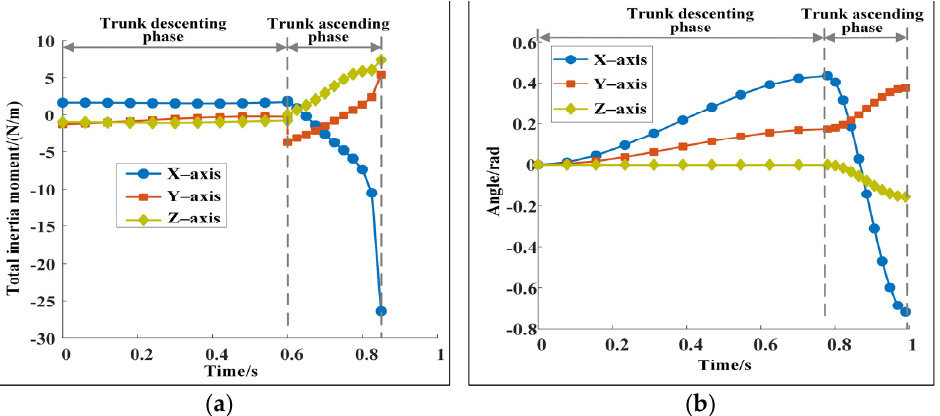
Figure 7. ( a ) Change of the total inertia moment when the trunk is forced horizontally. The maximum value of the total inertia moment is 27.97 N·m, which is much greater than the value shown in Figure 4a. ( b ) A possible trunk posture change rule. Although the corresponding total inertia moment is within a reasonable range, the maximum pitching angle of the trunk is 41.28°, which is not conducive to the stability of the robot.